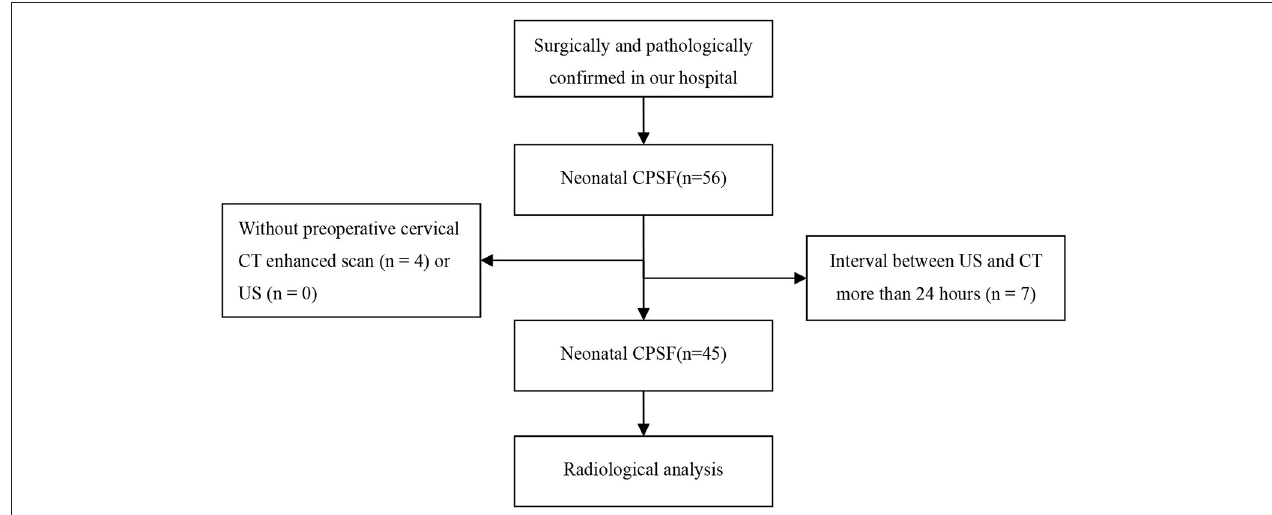
FIGURE 1 | Flowchart of the present